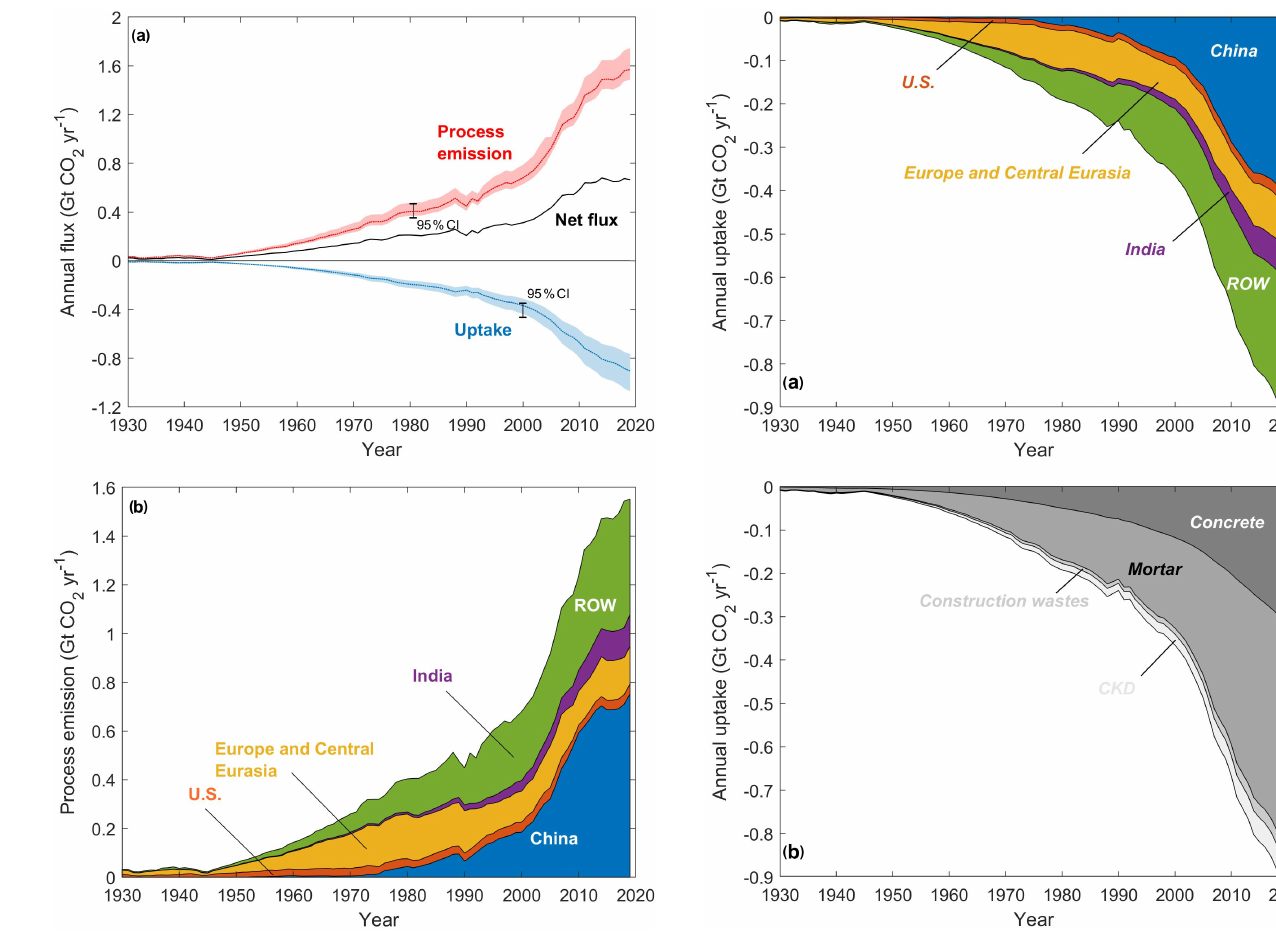
Figure 4. (a) Annual CO 2 process emission and uptake from pro- ducing and utilising cement materials from 1930 to 2019. The dot- ted lines denote the median values, while the respective shaded area denotes the 95% confidence interval from Monte Carlo simula- tions. The net emission is also illustrated with the solid black line; (b) the country- and region-wise process CO 2 emission (median) from 1930 to 2019.